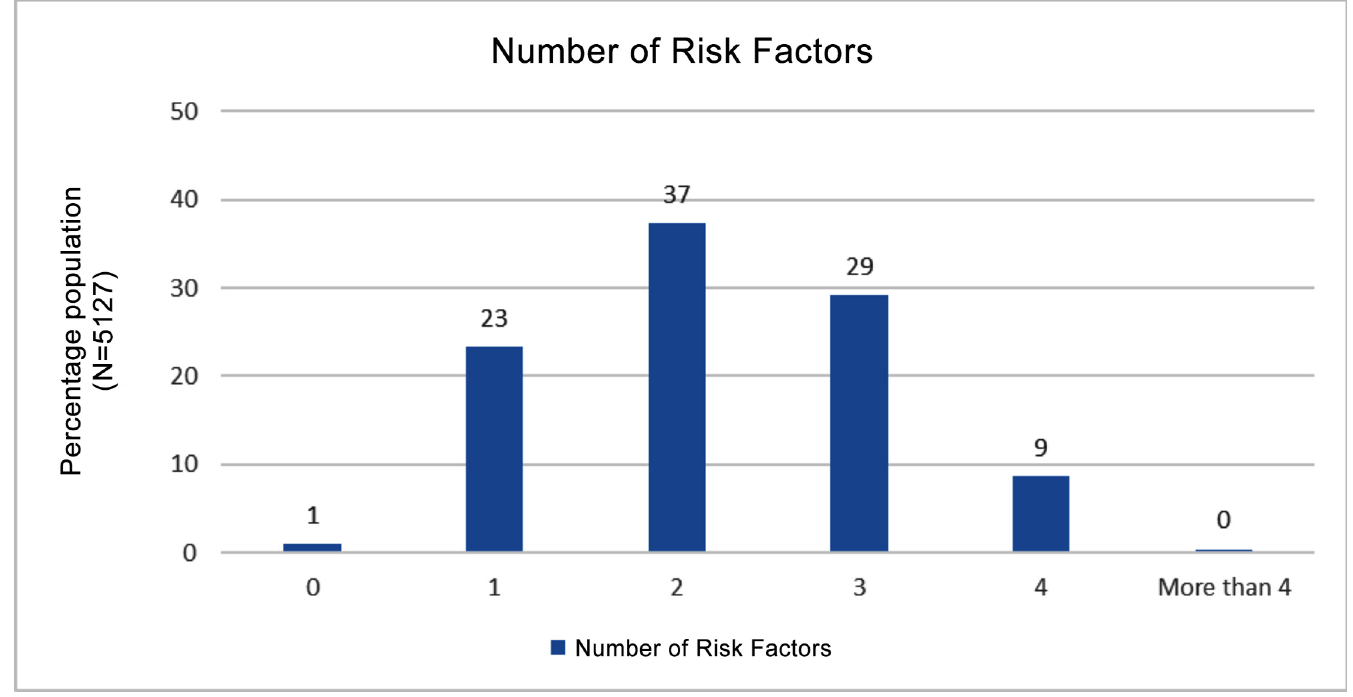
Fig 1. Percentage of participants with number of high risk factors for